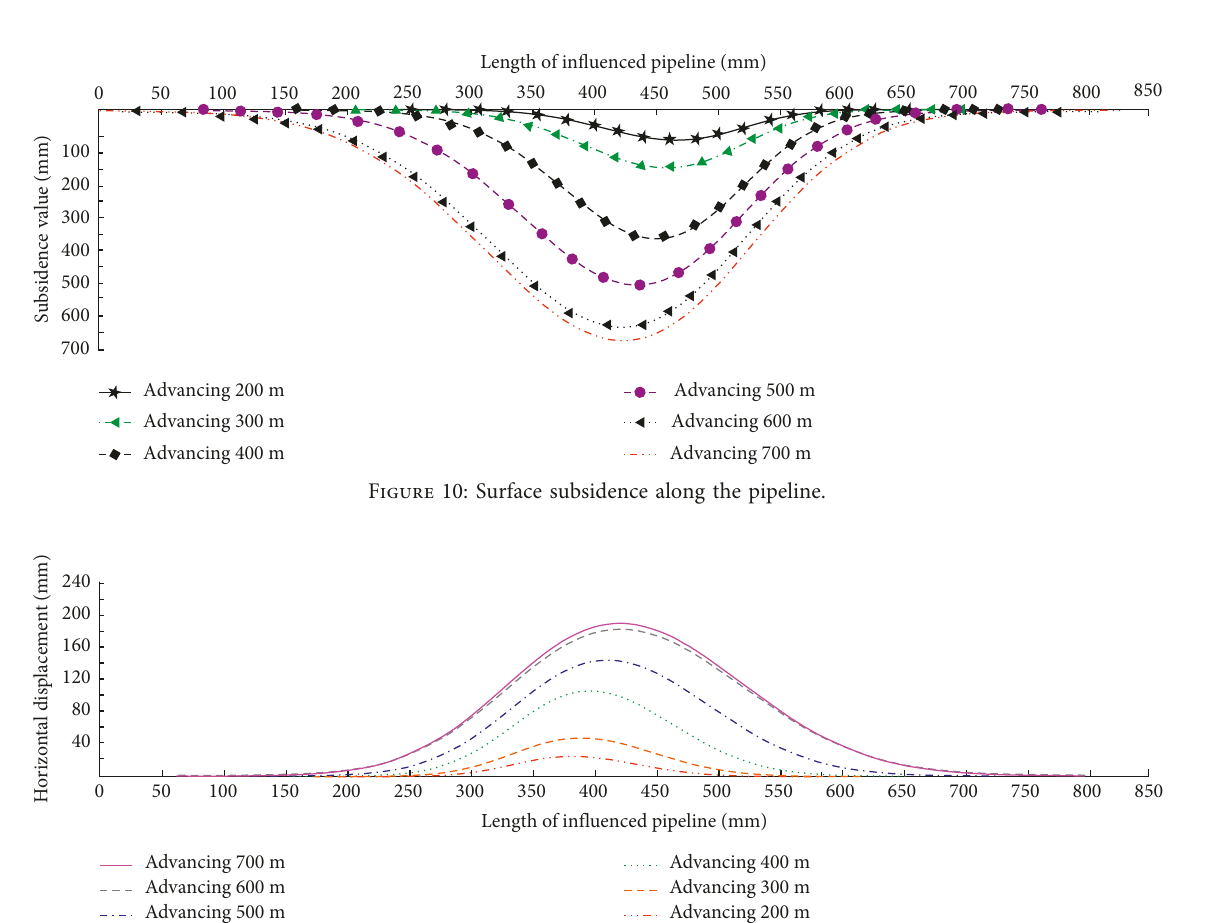
Figure 11: Horizontal surface displacement perpendicular to the pipeline.